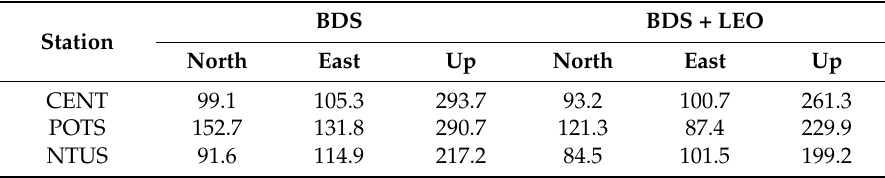
Table 7. SPP precision of both BDS and BDS + LEO